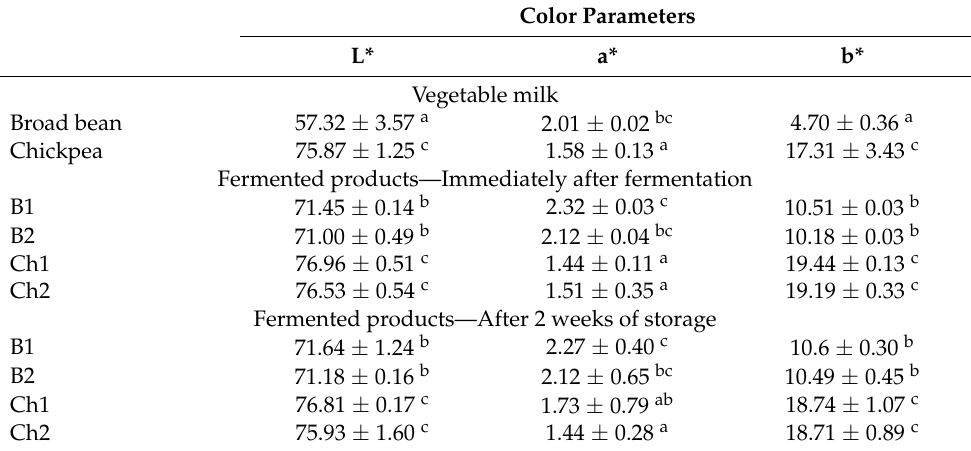
Table 5. CIELAB color parameters of obtained vegetable milk and lactic acid fermented vegetable products (yoghurt